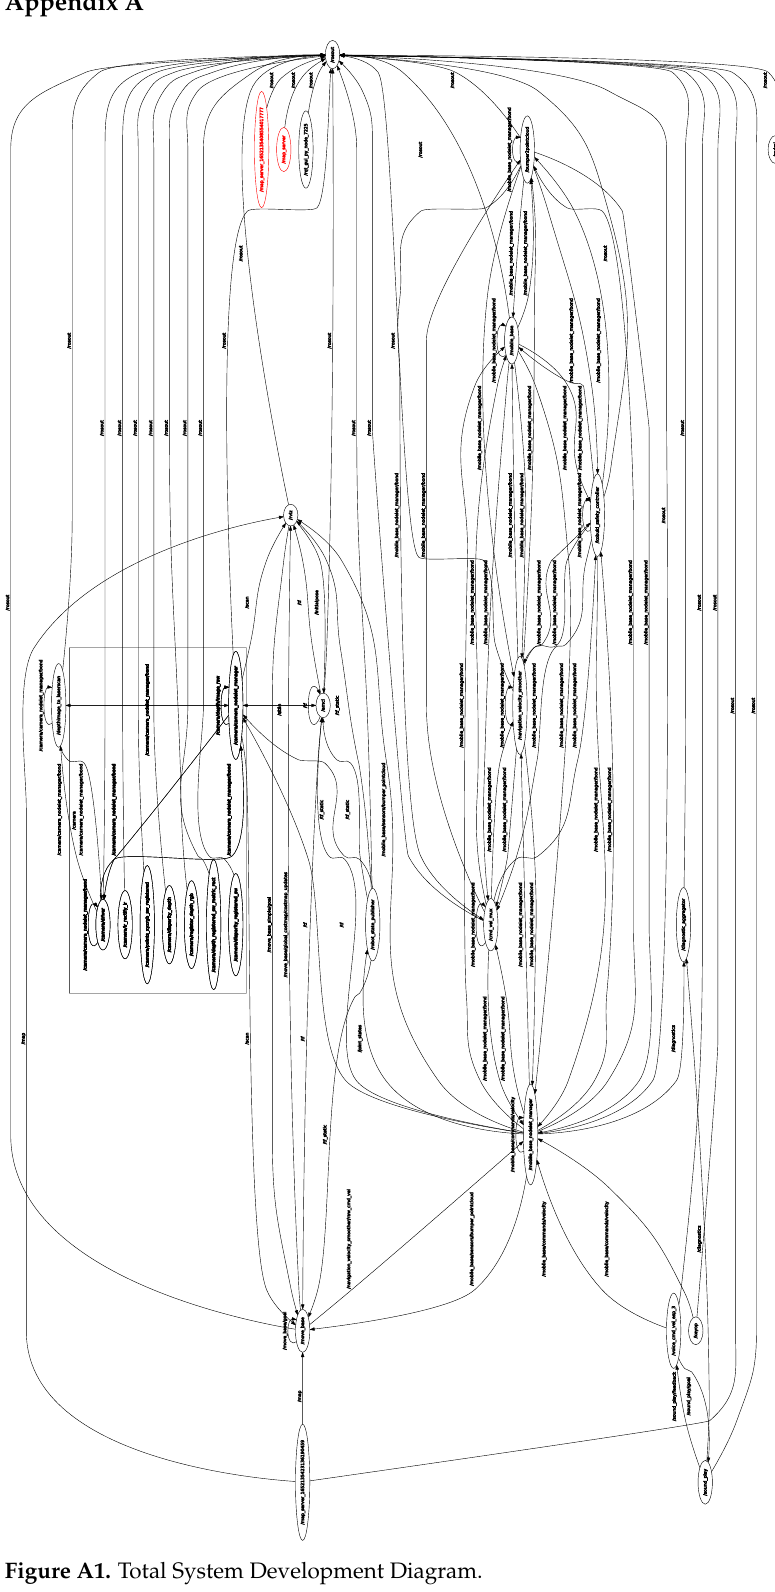
Figure A1. Total System Development